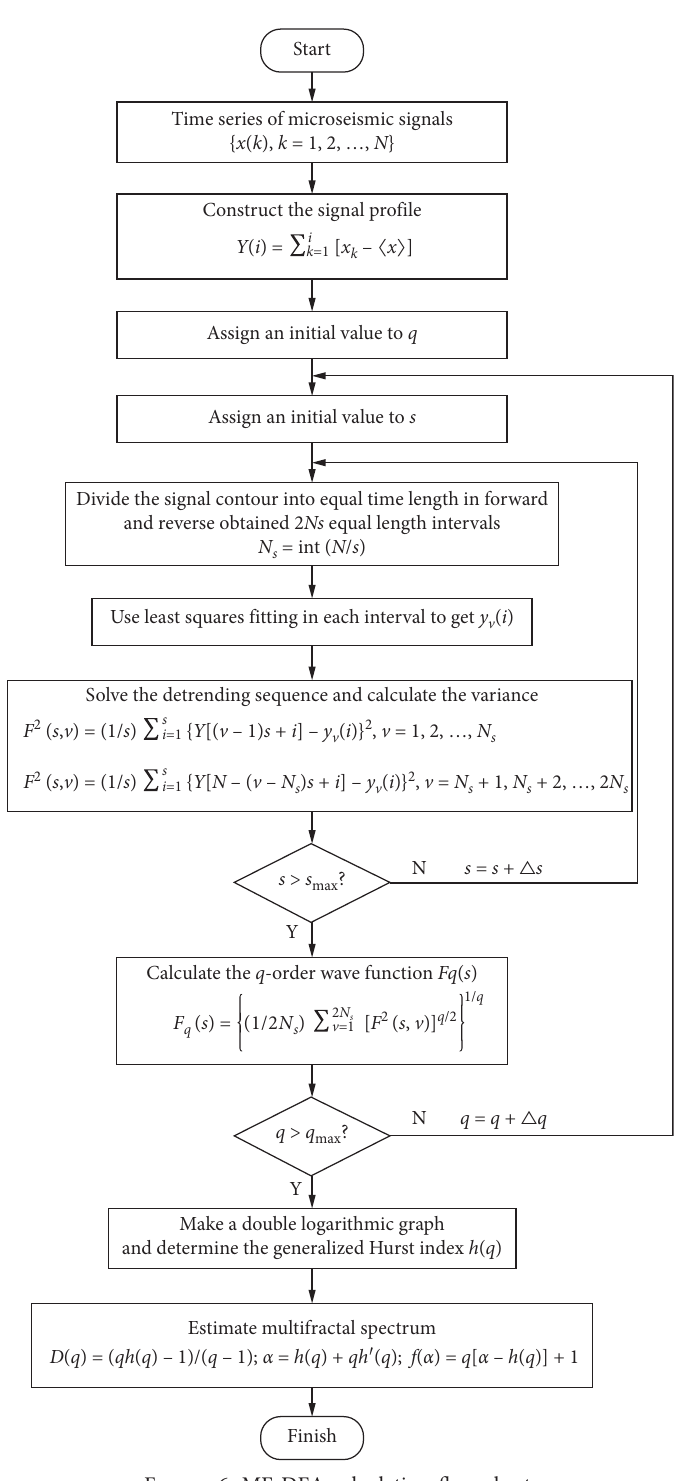
Figure 6: MF-DFA calculation flow